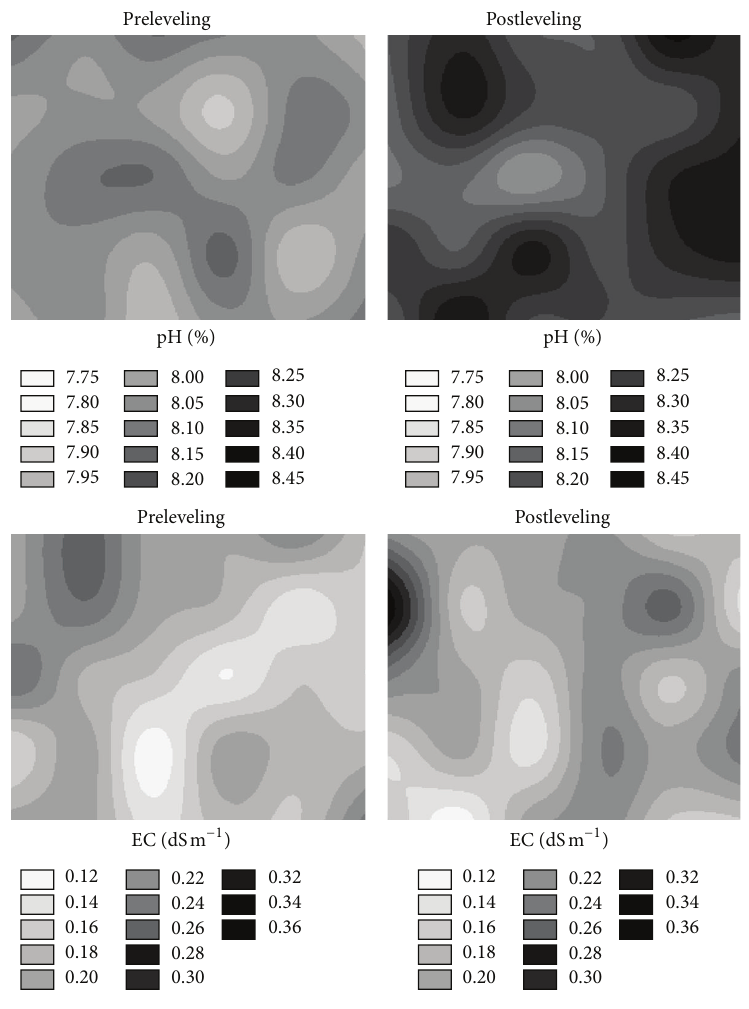
Figure 5: Pre- and post-leveling spatial distributions of soil pH, electrical conductivity (EC), and available water holding capacity (AWHC) in surface soil